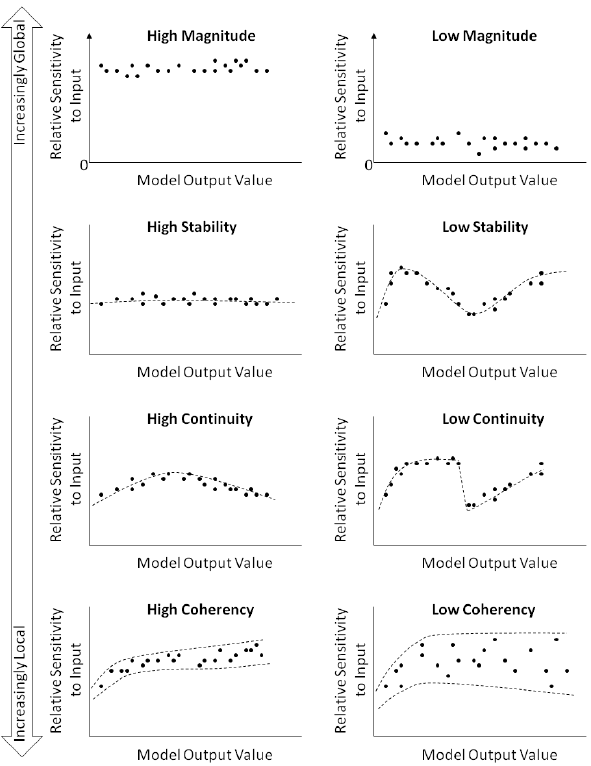
Fig. 4. Characteristic patterns of relative sensitivity. The continuum indicated by the arrow on the left indicates the relative focus of each sensitivity characteristic on a range between global and